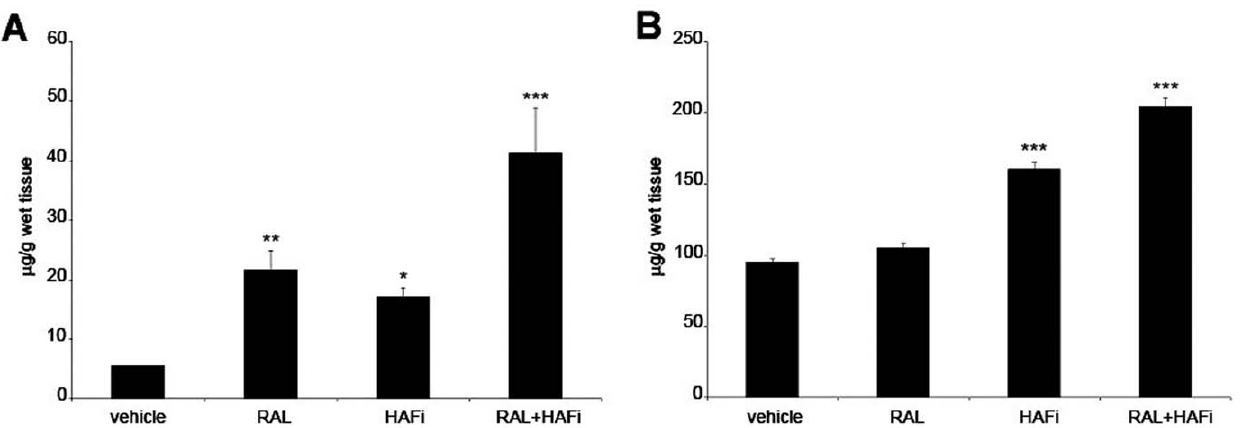
Figure 4. RAL and HAFi have a synergistic effect on the epidermal and dermal HA production in mouse skin. Epidermal (A) and dermal (B) HA content of vehicle-, RAL, HAFi- or RAL- and HAFi-treated skin of SKH1 hairless mice quantified by an enzyme-linked binding protein assay. The results are presented as the mean HA concentration 6 SEM of six animals per group. ***p , 0.001 versus vehicle; **p , 0.01 versus vehicle; *p , 0.05 versus vehicle (student’s t test).